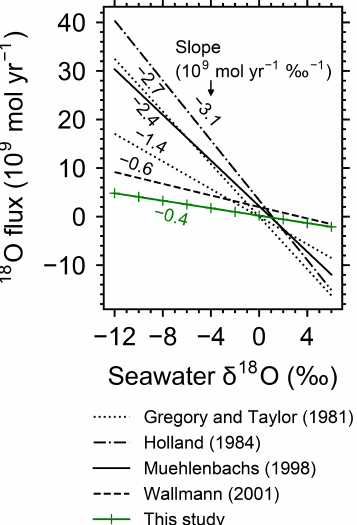
Figure 6. Net 18 O flux to the ocean from hydrothermal systems as a function of seawater δ 18 O. Slope values are denoted near the lines from previous studies and the standard simulation in this